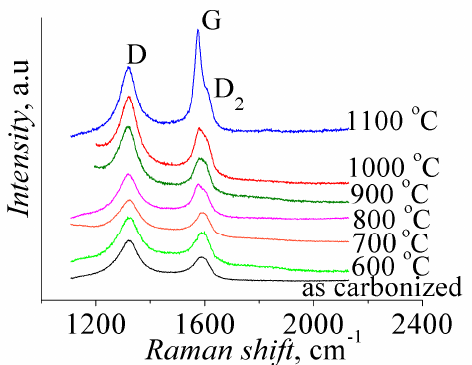
Figure 8. First-order Raman spectra of carbon in samples with Ni heat-treated at different tempera- tures shown in the graph.